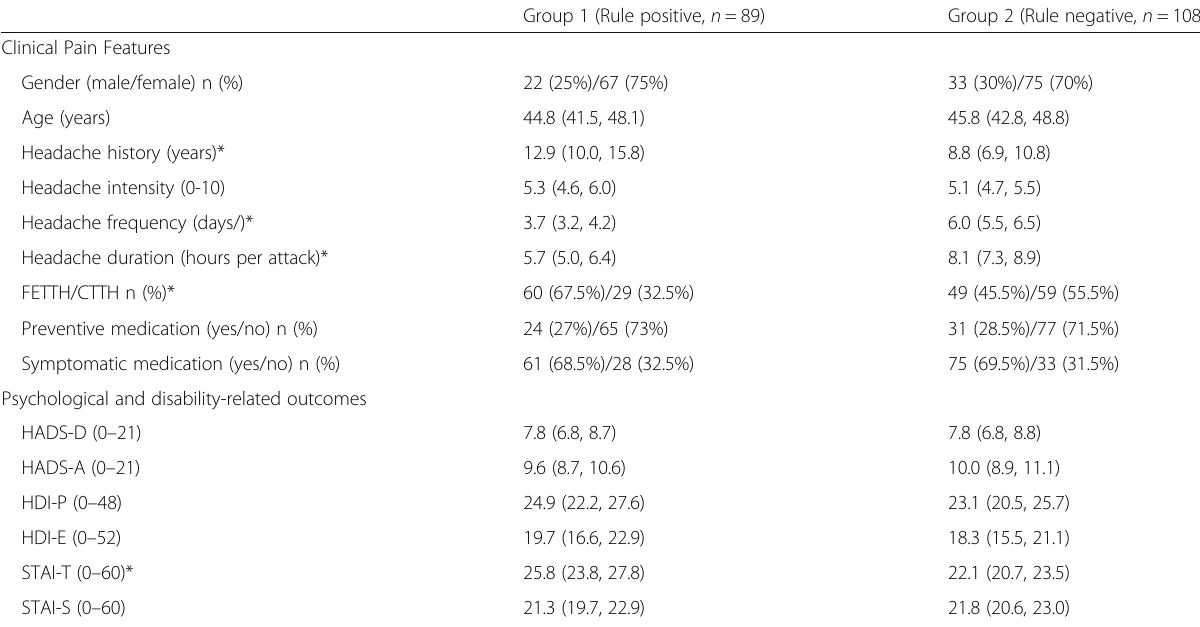
Table 1 Clinical features, medication intake, psychological and related-disability outcomes in patients with tension-type headache by